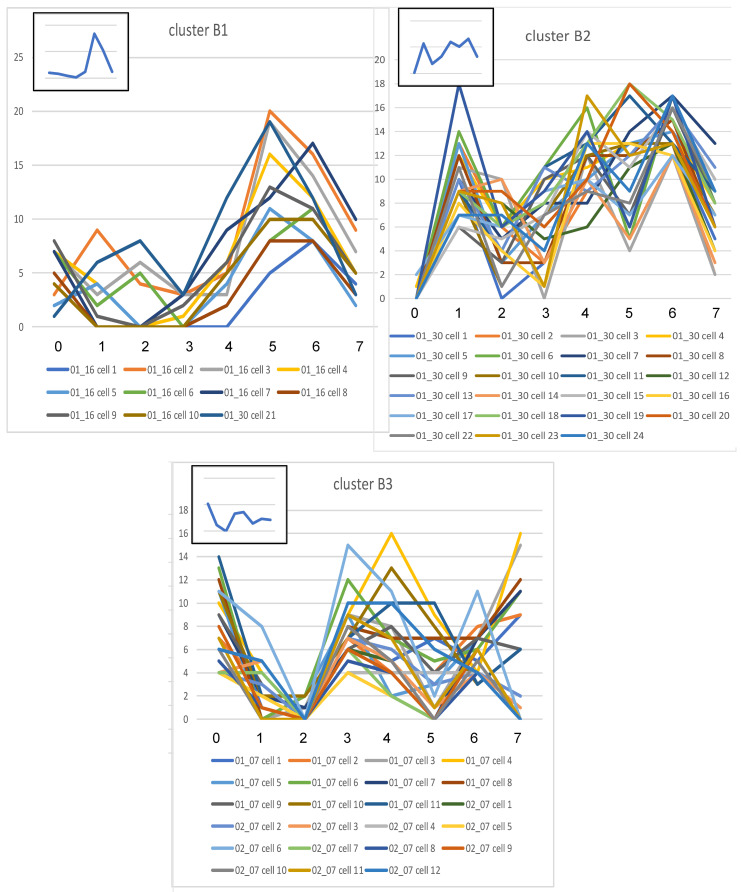
Signatures for cells in SP-A1 clusters.Line graphs from the cells composing each of the 3 main clusters (B1, B2, B3 — Figure 4B) for all AMs from SP-A1 mice are shown. Details are as described in legend for Figure 5.